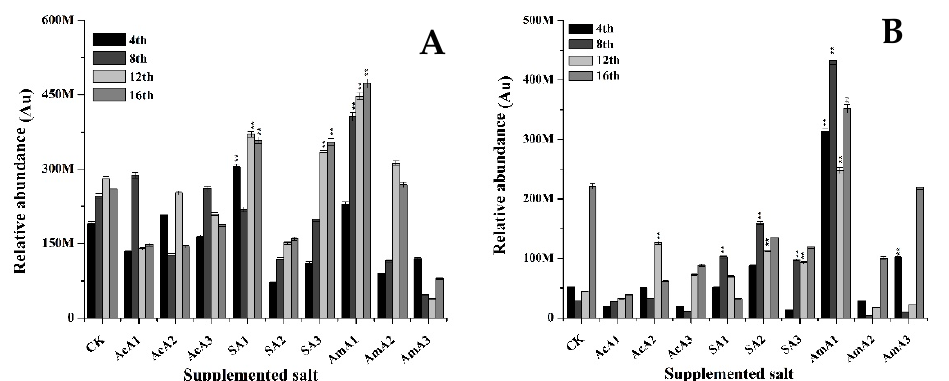
Figure 4. Ankaflavin value of M. ruber M7 grown over PDA spiked with acetic acid, sodium acetate and ammonium acetate at different concentrations. Acetic acid: AcA1: 0.1%, AcA2: 0.25%, AcA3: 0.5%; Sodium acetate: SA1:0.1%, SA2: 0.25%, SA3: 0.5%; Ammonium acetate: AmA1: 0.1%, AmA2: 0.25%, AmA3: 0.5%; CK: Controlled Kinetics. Error bars show the standard deviation among the treatments. **: highly significant ( p < 0.01). ( A ) Intracellular contents. ( B ) Extracellular contents.